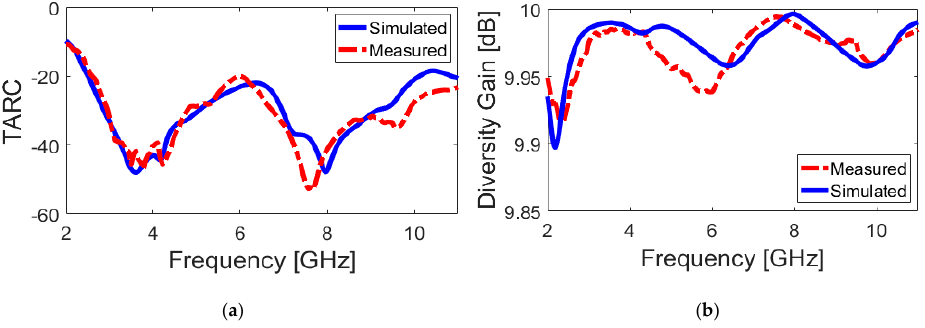
Figure 13. Calculated ( a ) TARC and ( b ) DG results from the measured and simulated results.